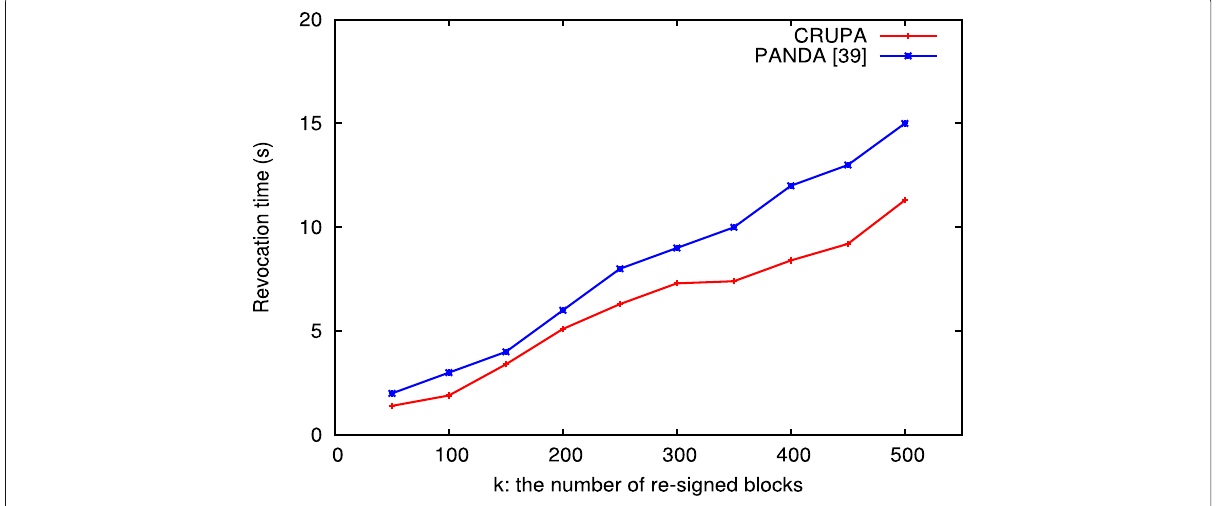
Fig. 4 Revocation time with re-signing of blocks by the CSP